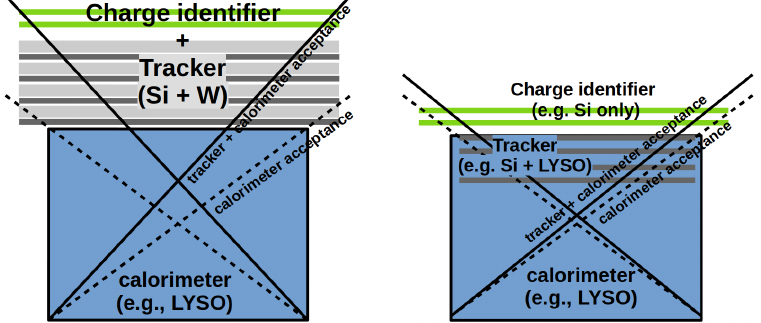
Figure 1. Conceptual designs of the two different detector geometries for γ -ray physics: on the left , the standard approach with a external tracker on the top of a calorimeter, and on the right , the TIC approach with a silicon tracker integrated inside a